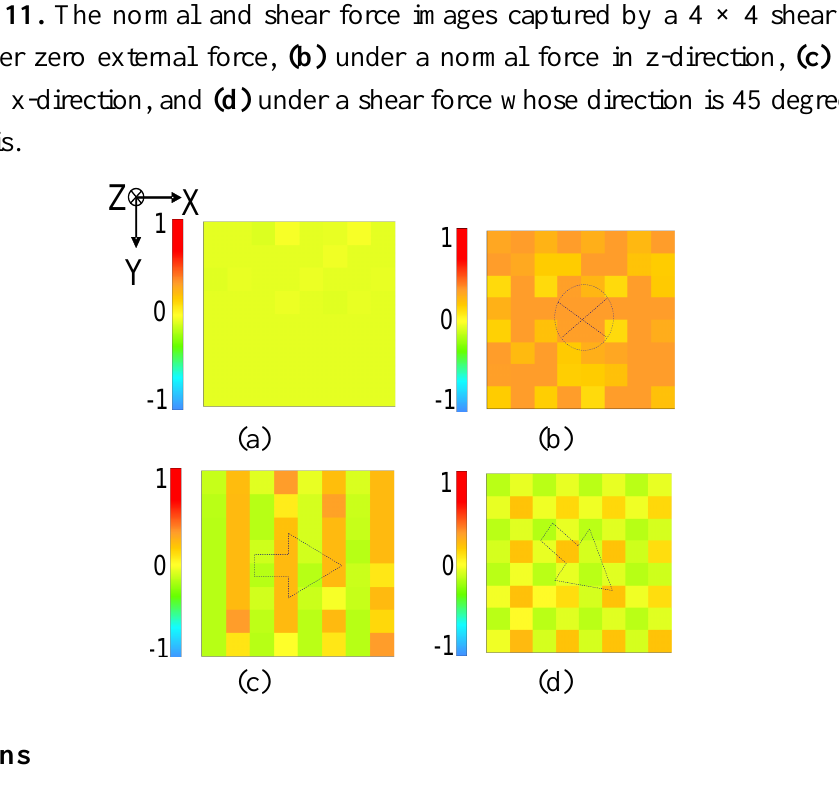
(a) under zero external force, (b) under a normal force in z-direction, (c) under a